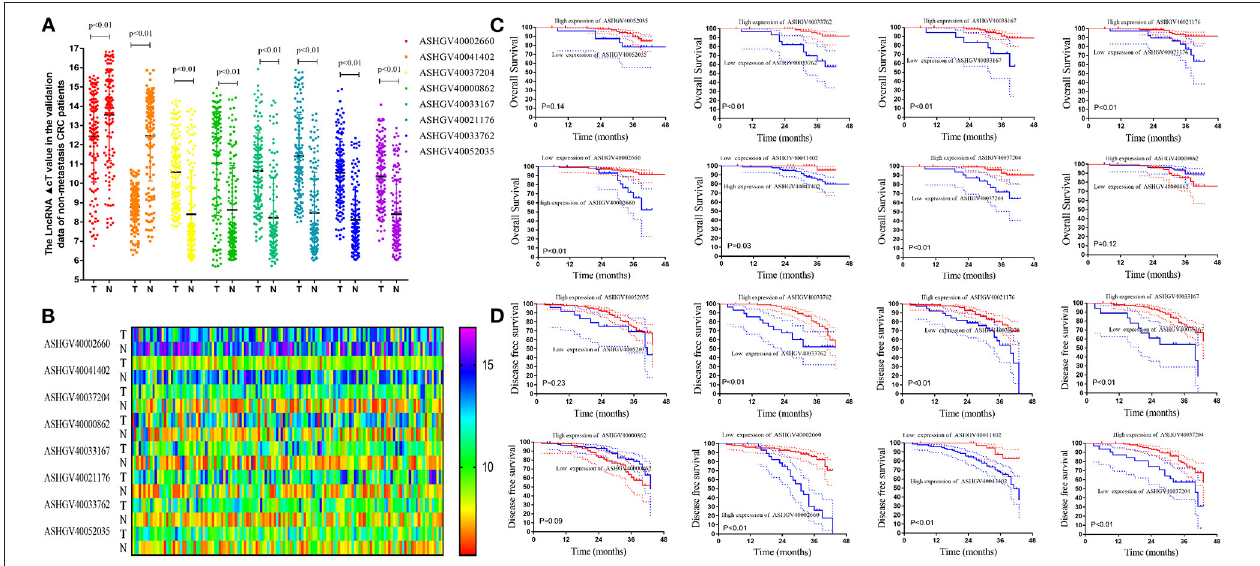
FIGURE 5 | External validation of hub long non-coding RNAs (lncRNAs) in the non-metastatic colorectal cancer (CRC) patients. (A) The hub lncRNAs 1 Ct value in the cancerous tissue and adjacent non-cancer tissue in external CRC patients by quantitative PCR (qPCR) (all P < 0.01). (B) The heatmap of the 1 Ct value. (C) The Kaplan–Meier analysis for the overall survival of the hub lncRNAs in the non-metastatic CRC patients. (D) The Kaplan–Meier analysis for the disease-free survival of the hub lncRNAs in the non-metastatic CRC